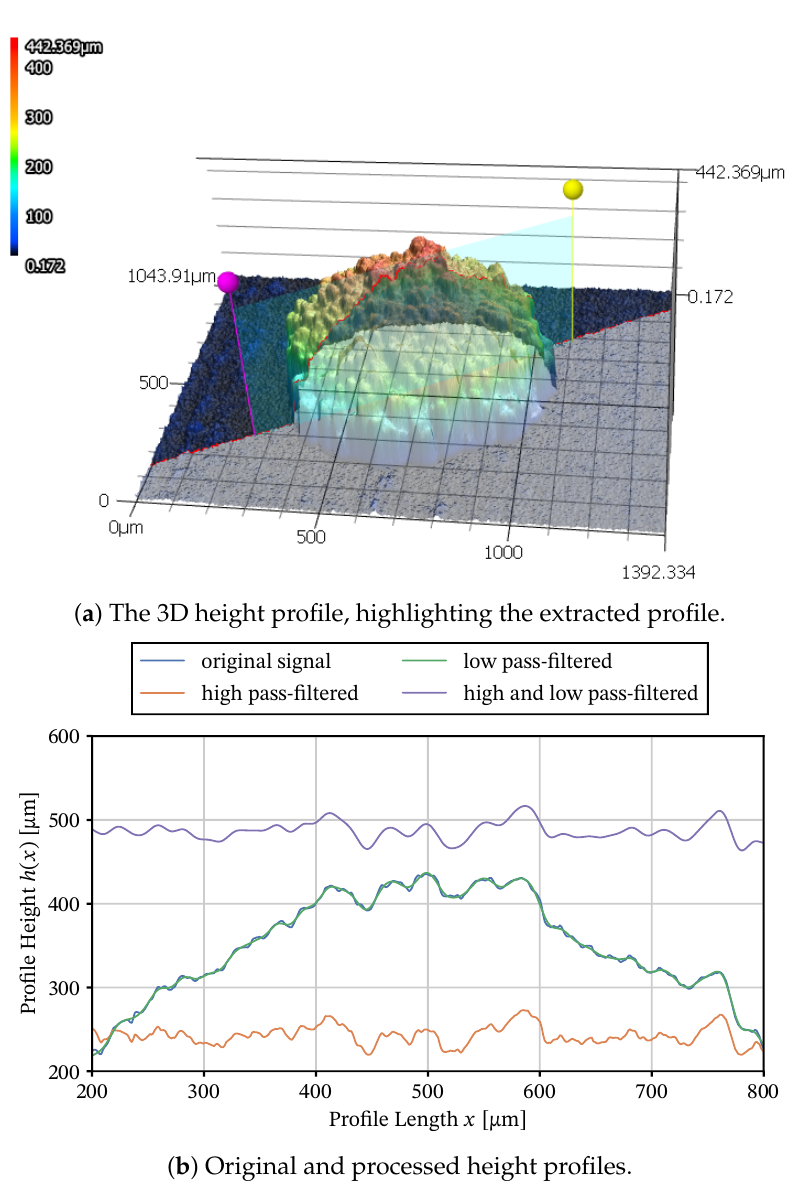
Figure 3. Example result of laser-scanning confocal microscopy: 3D profile ( a ) and post-processing of extracted line profile for later roughness calculation ( b